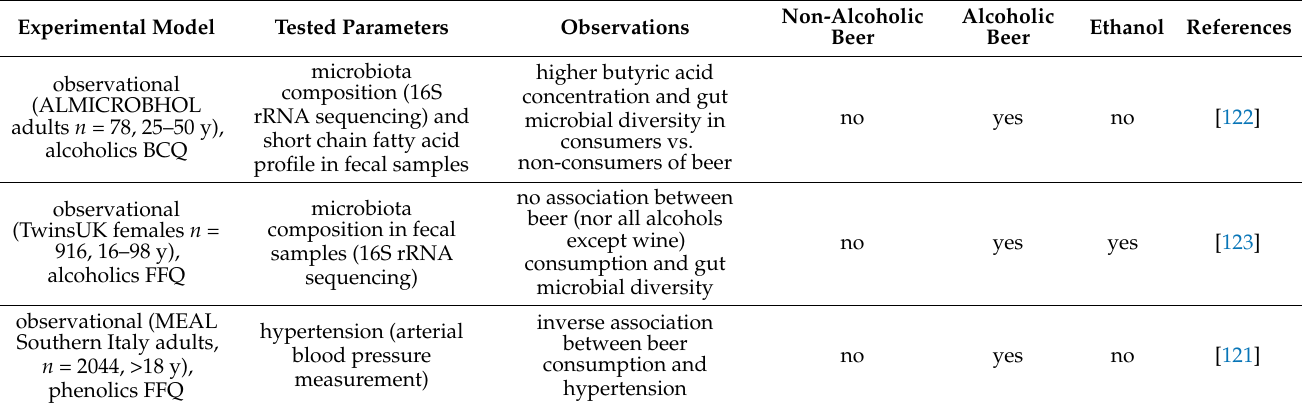
Table 3. Observational studies ( n , subjects’ number; y, age